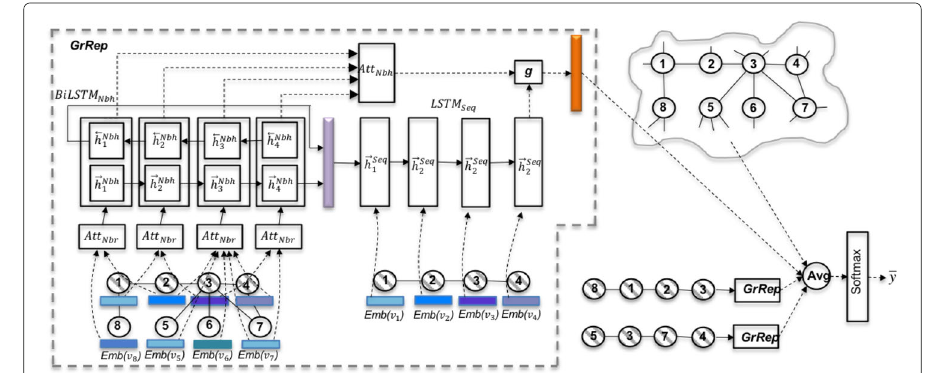
Fig. 7 Supervised graph representation